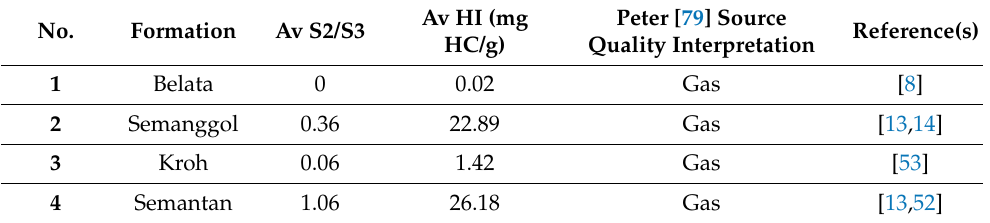
Table 5. Source quality interpretation of formations in PM using Peter [79]